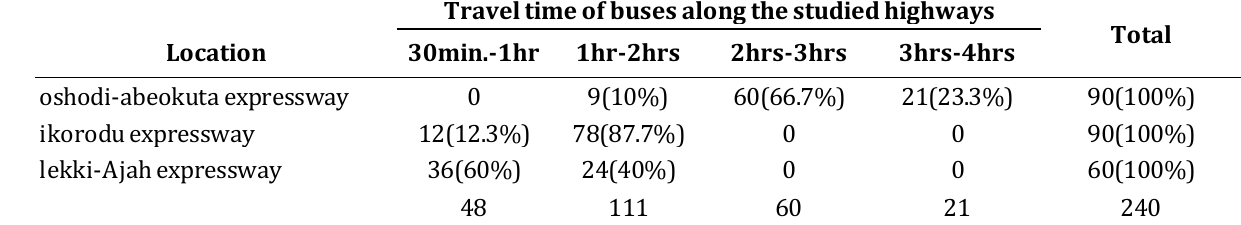
Table 5: Reported travel time of buses along the studied highways in Lagos Metropolis